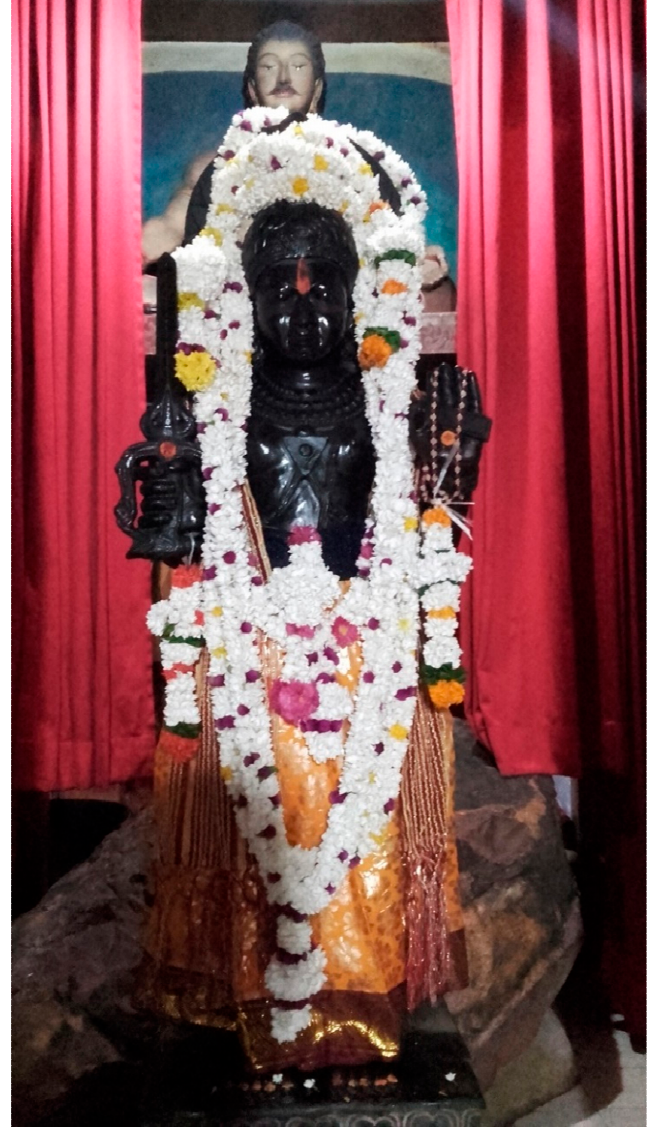
Figure 3. Statue of Ravana in the Sri Lankesvara maha Ravana raja mandiraya . The statue is richly decorated after the annual maha Ravana nanumura mangalyaya . Picture taken by author, 25 March 2018.